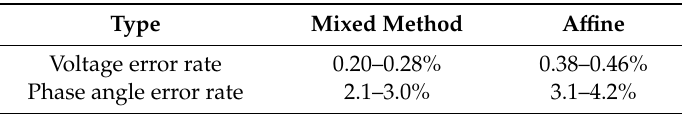
Table 5. Relative error